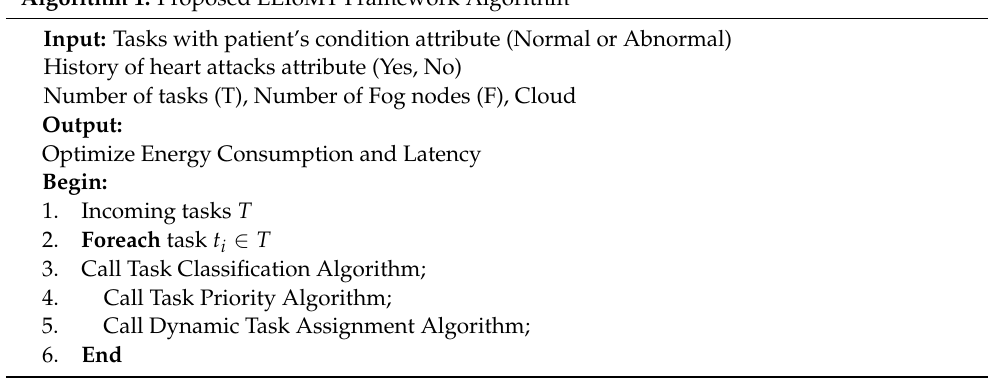
Algorithm 1. Proposed EEIoMT Framework